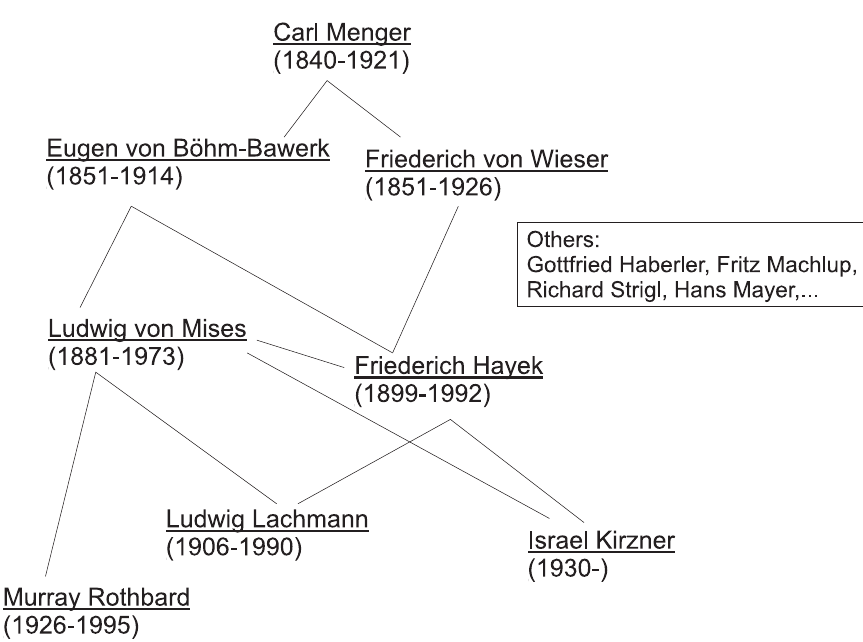
Figure 1: The Austrian School of Economics from inception to the third